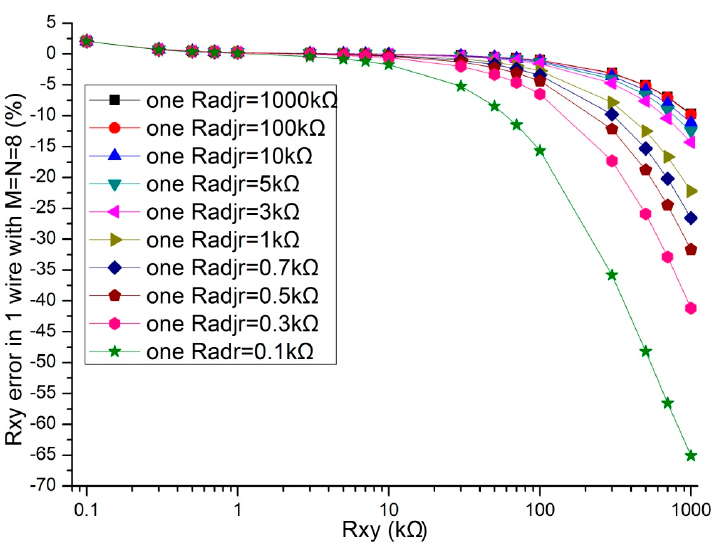
Figure 5. The R adjr effect on R xy errors in the one-wire VF-NSDE circuit.